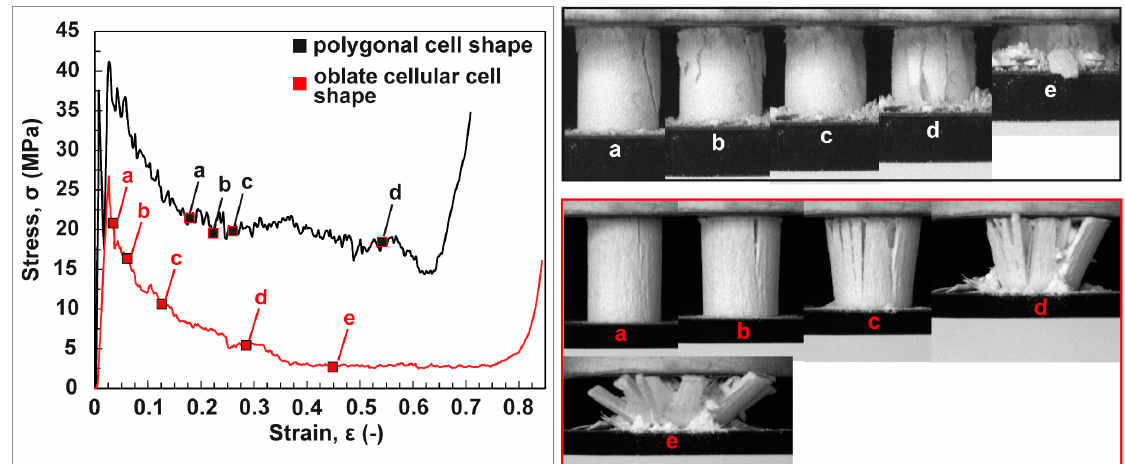
Figure 17. The plots in ( A , B ) show the average Young’s modulus and maximum compressive strength of the freeze-casted ceramics as a function of the porosity, Φ .